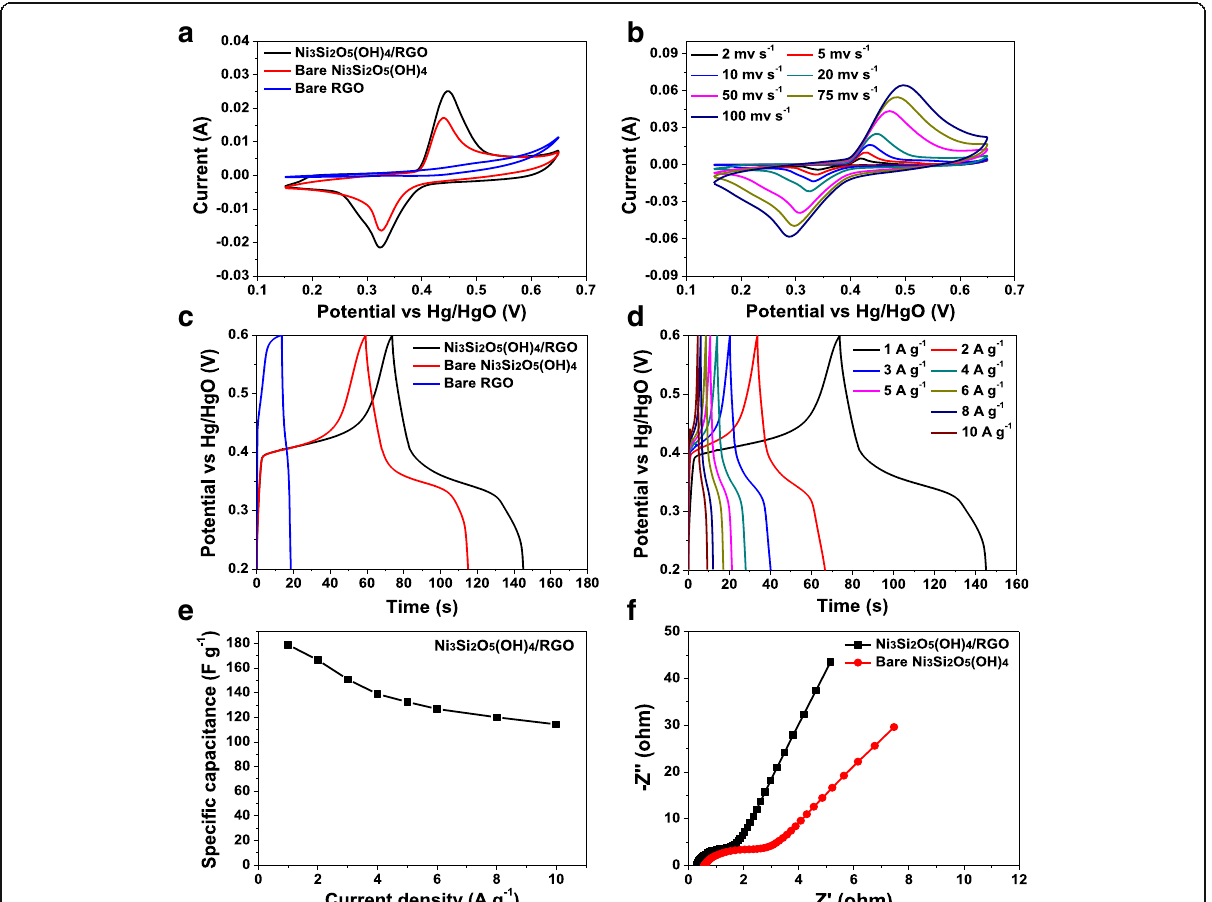
Fig. 7 a CV curves of Ni 3 Si 2 O 5 (OH) 4 /RGO hollow microspheres ( black curve ), bare Ni 3 Si 2 O 5 (OH) 4 hollow microspheres ( red curve ), and bare RGO material ( blue curve ) tested at the scanning rate of 20 mV s – 1 in 2 M KOH. b CV curves of Ni 3 Si 2 O 5 (OH) 4 /RGO hollow microspheres tested at a series of different sweeping rates. c GCD curves of Ni 3 Si 2 O 5 (OH) 4 /RGO hollow microspheres ( black curve ), bare Ni 3 Si 2 O 5 (OH) 4 /RGO microspheres ( red curve ) and bare RGO material ( blue curve ) at the current density of 1 A g – 1 . d GCD curves of Ni 3 Si 2 O 5 (OH) 4 /RGO hollow microspheres measured at a set of varied current densities. e Specific capacitance of Ni 3 Si 2 O 5 (OH) 4 /RGO hollow microsphere electrode deduced from the GCD curves depicted in d as a function of current density. f Nyquist plots of Ni 3 Si 2 O 5 (OH) 4 /RGO hollow microsphere ( black curve ) and